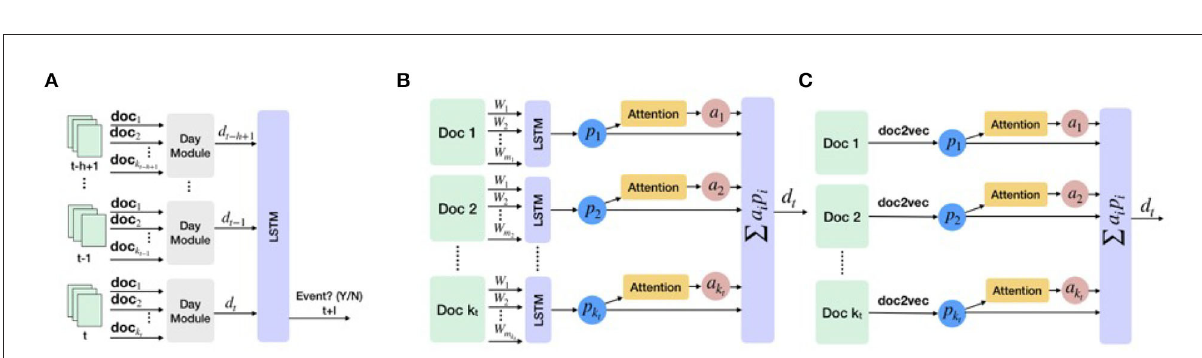
FIGURE3 Overview of the proposed framework using attention-based LSTM. (A) The overall structure of the attention-based LSTM model. (B) Day module in EPIAL learns representation for each document and its attention score. (C) Day module in EPIAL-light replaces the first LSTM layer of EPIAL with document representation estimated using